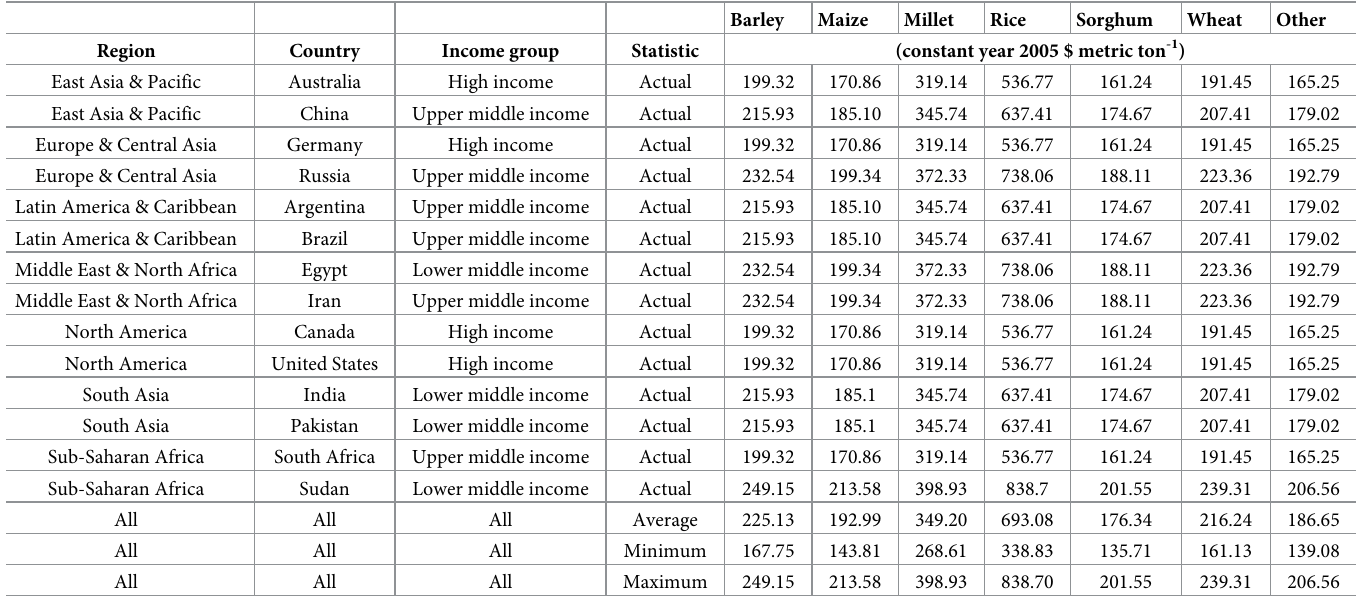
Table 3. Grain prices used in fourteen select countries and summary statistics of prices used in all 153 countries.